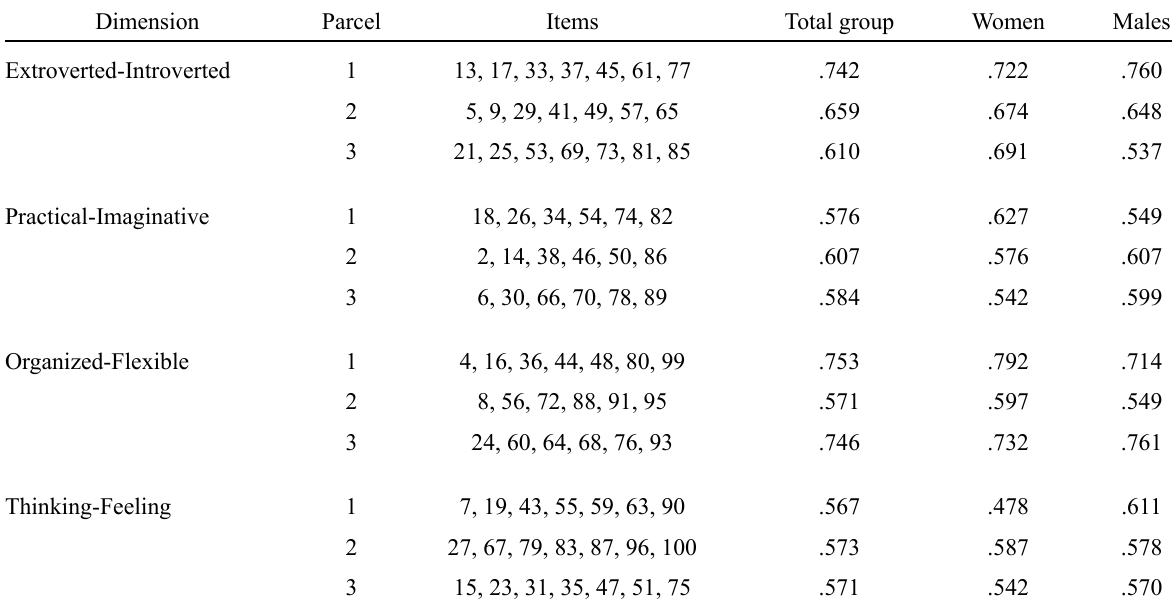
Descriptions of Parcels and Loadings of Parcels on Associated Styles Dimension Parcel Items Total group Extroverted-Introverted